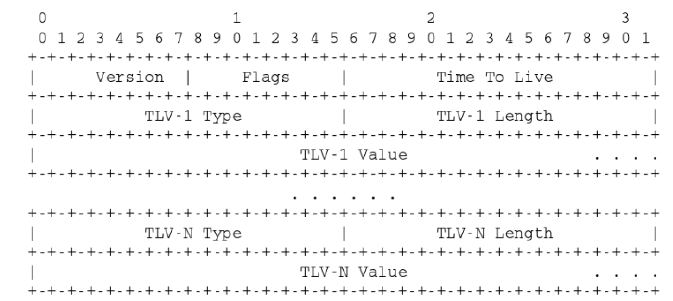
Figure 4. LLDP packet format. Adapted from